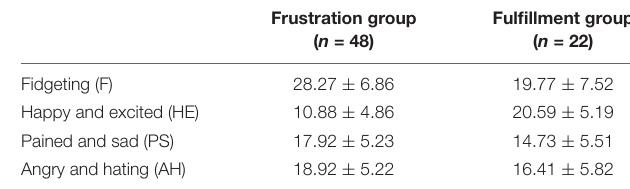
TABLE 2 | Chinese mood adjective check list scores (Mean and SD